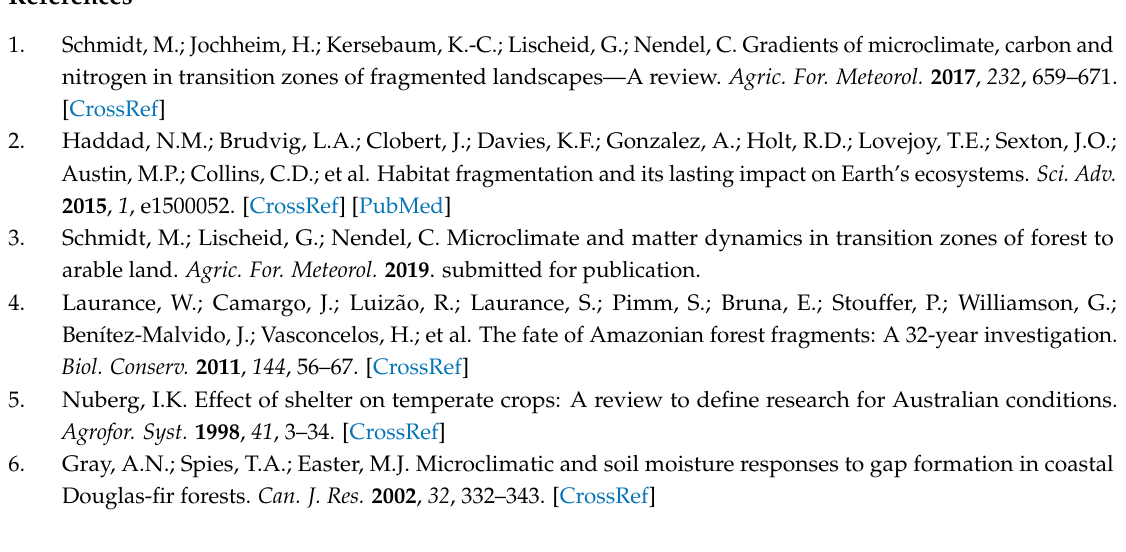
Table S1: Simulated solar irradiance (MJ m − 2 ) for the four cardinal directions (north (N), east (E), south (S), and west (W)) with respect to distance (m) to the zero line (Dist). The values represent the yearly average, Table S2: Simulated maize and wheat yields (kg ha − 1 ), as well as soil moisture (m 3 m − 3 ) for the four cardinal directions ( Dir ; north (N), east (E), south (S), and west (W)), with respect to the distance (m) to the zero line ( Dist ). The values represent an average for 30 years (Wheat n = 29, Maize n = 30). Dry and Moist are the means of the three driest and moistest years, in the climate